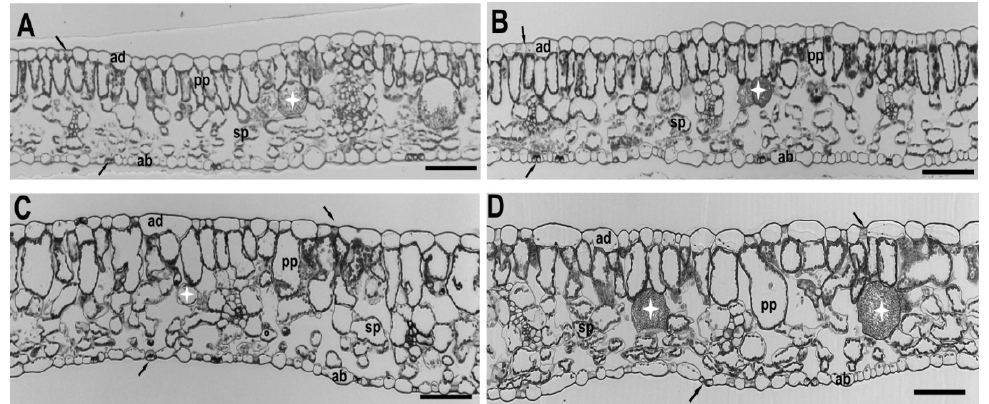
Figure 4. Effects of different lighting systems on the anatomies of the Capsicum leaves (cv. ‘Aifos’ or ‘Palermo’): ( A ) ‘Aifos’ HPS; ( B ) ‘Palermo’ HPS; ( C ) ‘Aifos’ LED; ( D ) ‘Palermo’ LED. Abbreviations: